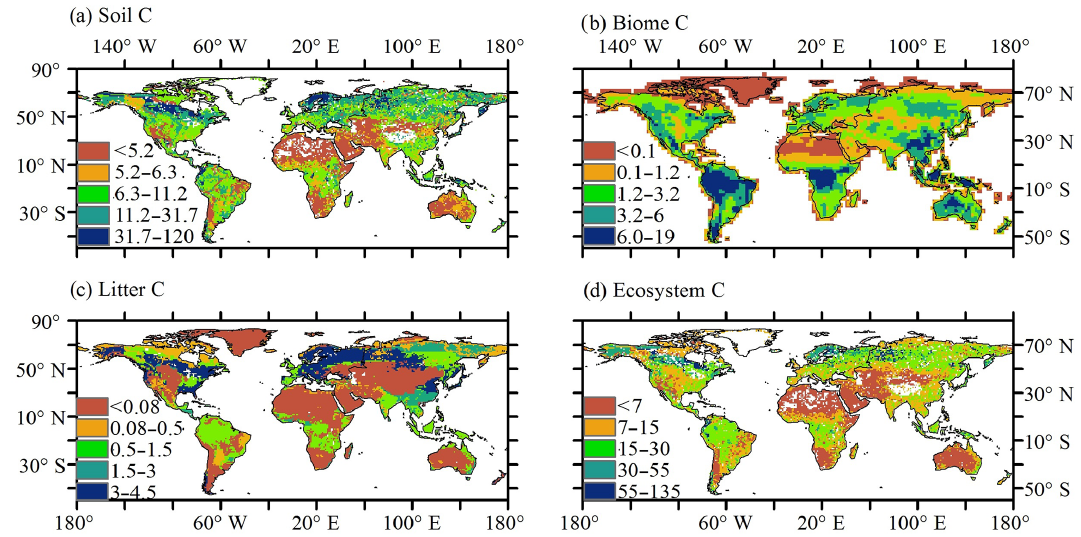
Figure 1. Spatial pattern of soil C (a) , biome C (b) , litter C (c) and ecosystem C storage (d) on the grid scale (1 ◦ × 1 ◦ ). Unit: kgCm − 2 . Ecosystem C storage was calculated from plant biomass, soil and litter C